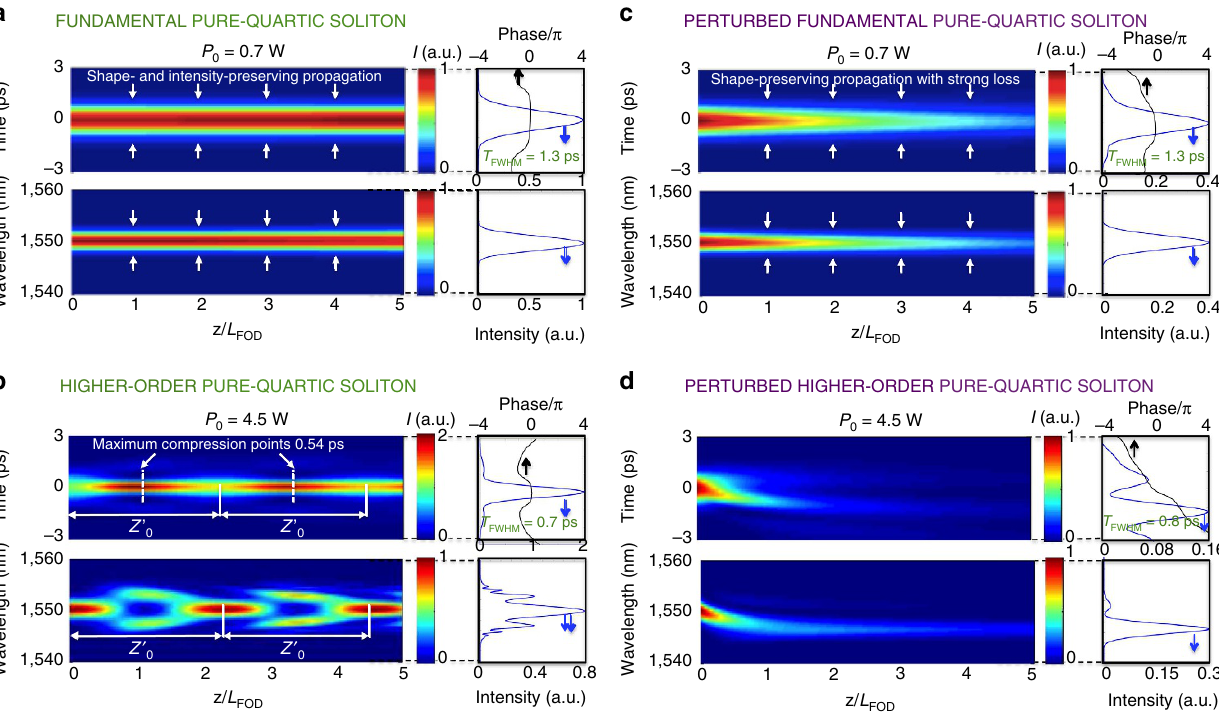
Figure 3 | Simulations of the propagation of a fundamental and a higher-order pure-quartic soliton along five quartic dispersion lengths, L FOD . ( a ) Fundamental ( P 0 ¼ 0.7W) pure-quartic soliton with only self-phase modulation and quartic dispersion present, and ( c ) in the more realistic scenario for our silicon waveguide with two-photon absorption and free carriers; ( b ) and ( d ) are similar but for a higher power level ( P 0 ¼ 4.5W) where a higher-order pure-quartic soliton